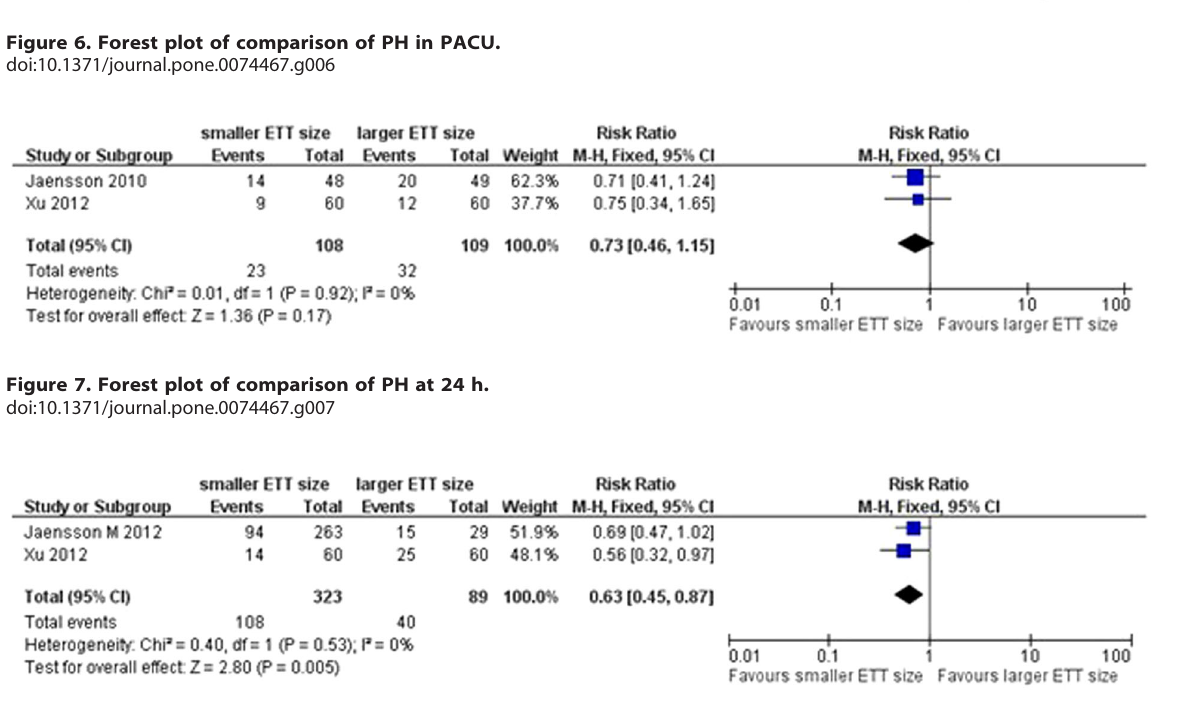
Figure 8. Forest plot of comparison of sensitivity analysis. doi:10.1371/journal.pone.0074467.g008 PLOS ONE |